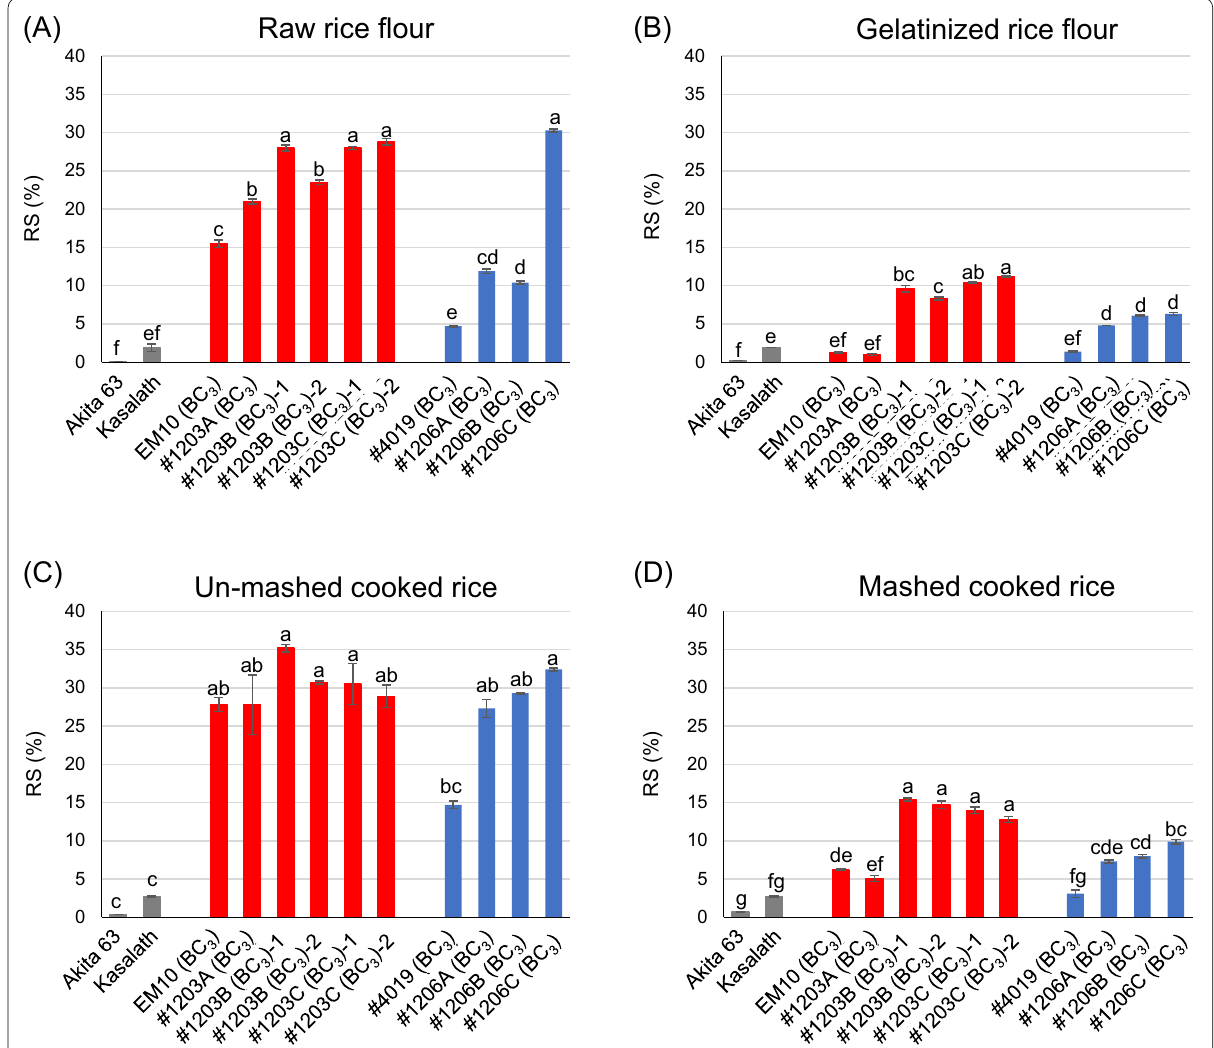
Fig. 6 RS contents of rice processed using different methods. a – d RS contents of raw rice flour ( a ), gelatinized rice flour ( b ), un-mashed cooked rice ( c ), and mashed cooked rice ( d ). Data represent mean rice genotypes ( P < 0.05; Tukey–Kramer